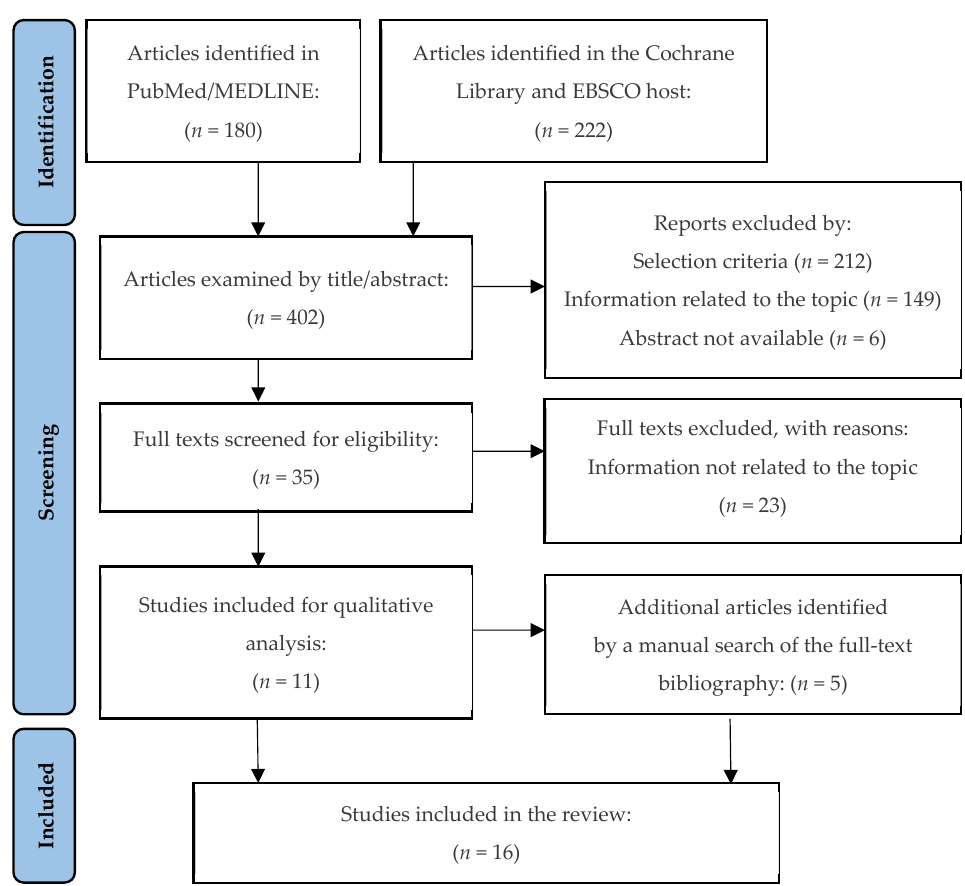
Figure 1. Flowchart showing the synthesis of the bibliographic search, according to the PRISMA guidelines.